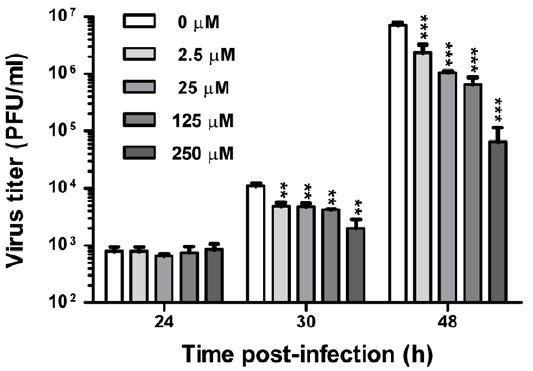
Figure 2. Meth reduces influenza A virus propagation in human lung epithelial A549 cells. A549 cells were left untreated or treated with meth at indicated concentrations for 24 h, followed by infection with human influenza virus strain A/WSN/33 (H1N1) at an MOI of 0.001 PFU/cell (trypsin present) in the presence of meth at respective concentrations. Virus progenies were collected at indicated time points, and subjected to plaque assays in MDCK cells to determine virus titers. Values are means 6 SD of three replicates from a representative result of three independent experiments. Significant differences from the meth-untreated control were indicated (**: p , 0.01, ***: p , 0.0001).